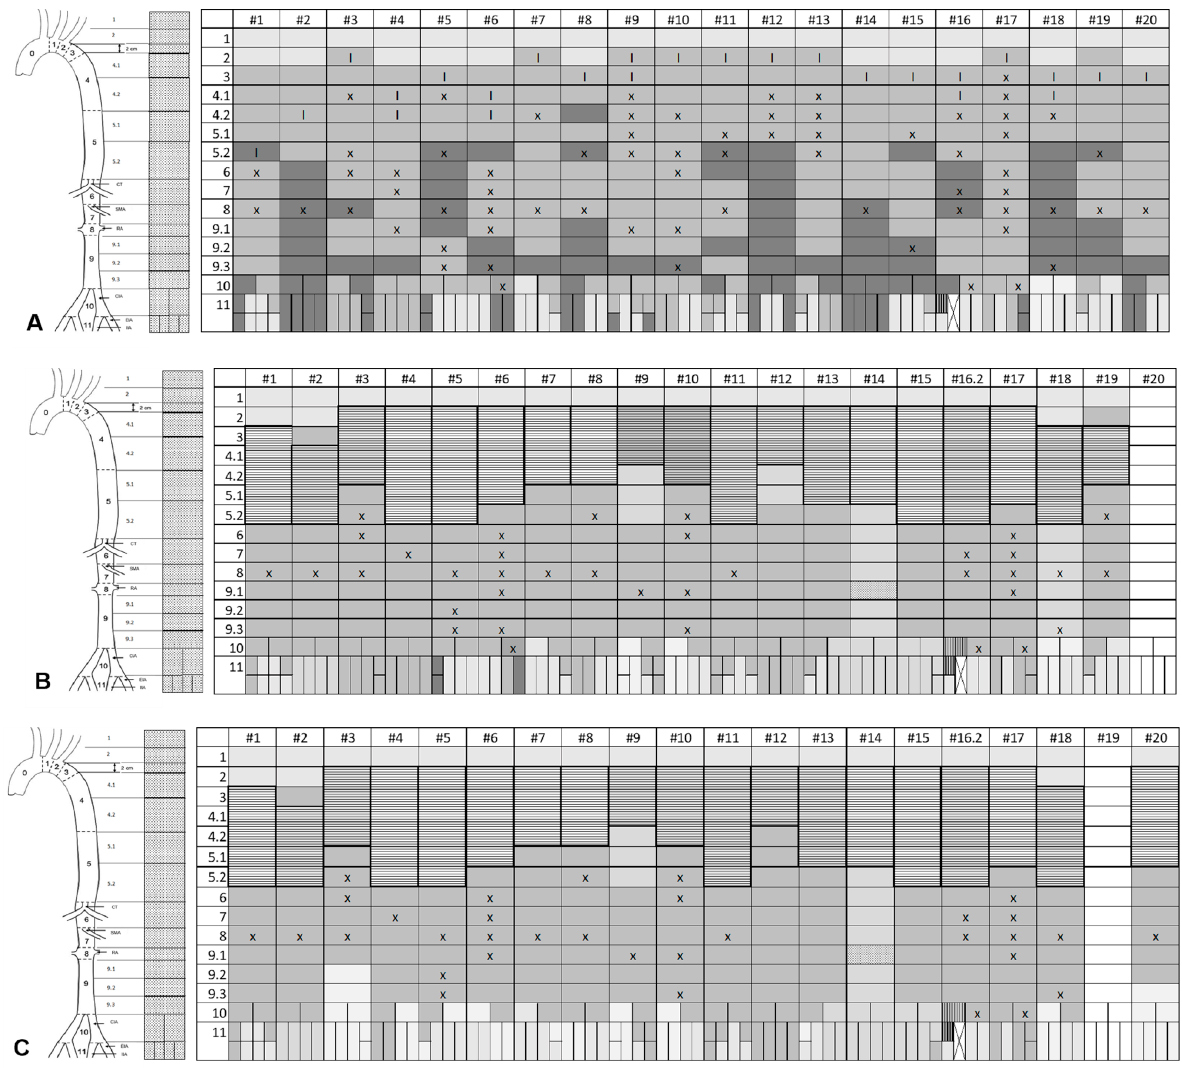
Figure 3. Morphological presentation before TEVAR ( A ), after TEVAR with respect to intraoperative angiography ( B ) and after treatment, including a potential extremity related adjunct procedure ( C ).